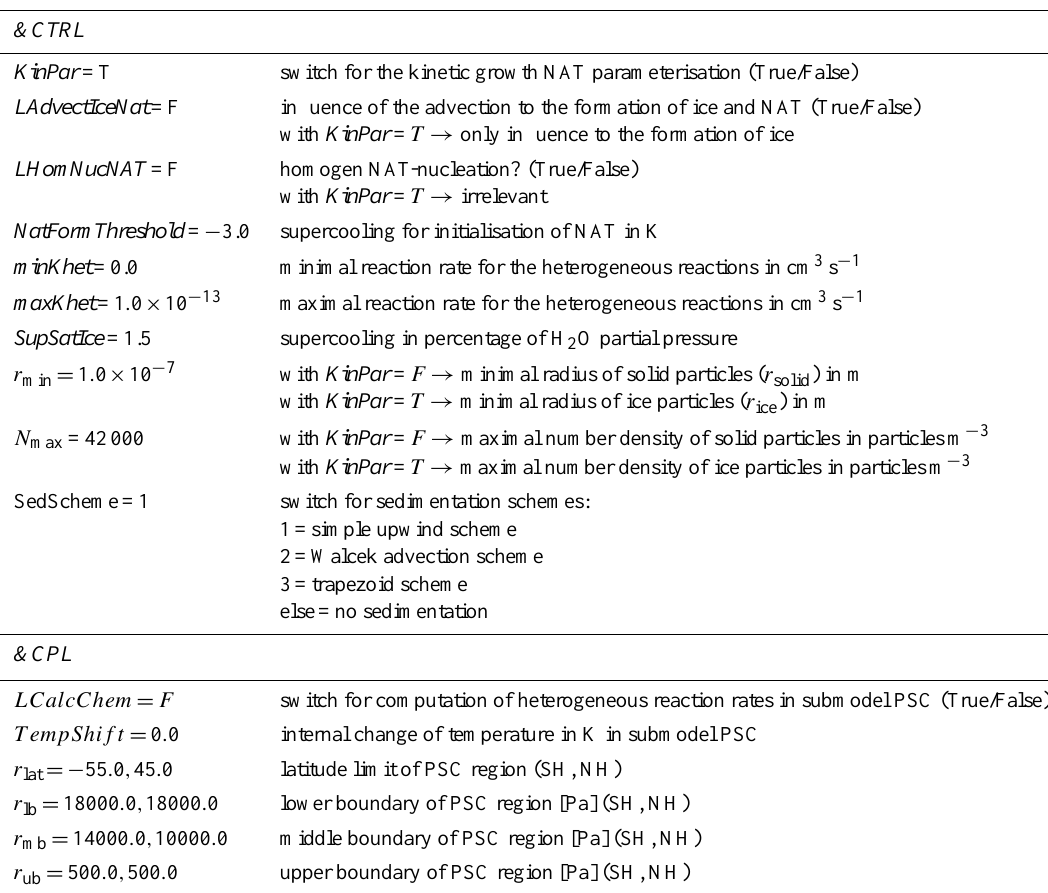
Table 4. The PSC Submodel CTRL and CPL namelists in the namelist file psc.nml, which is part of the MESSy user interface. The settings have been used for the simulation which results are presented in Sect.